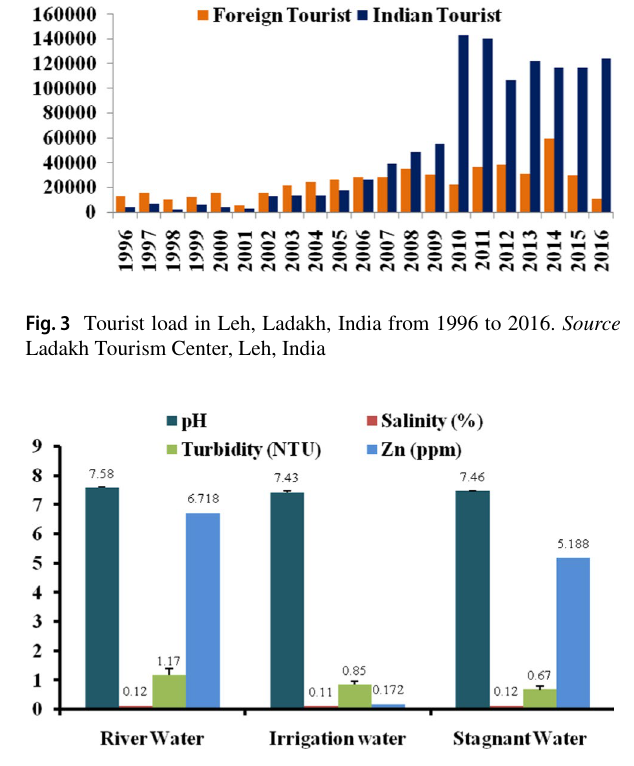
Fig. 4 Level of pH, turbidity, salinity, and Zn level in different sources of water from high-altitude region of India